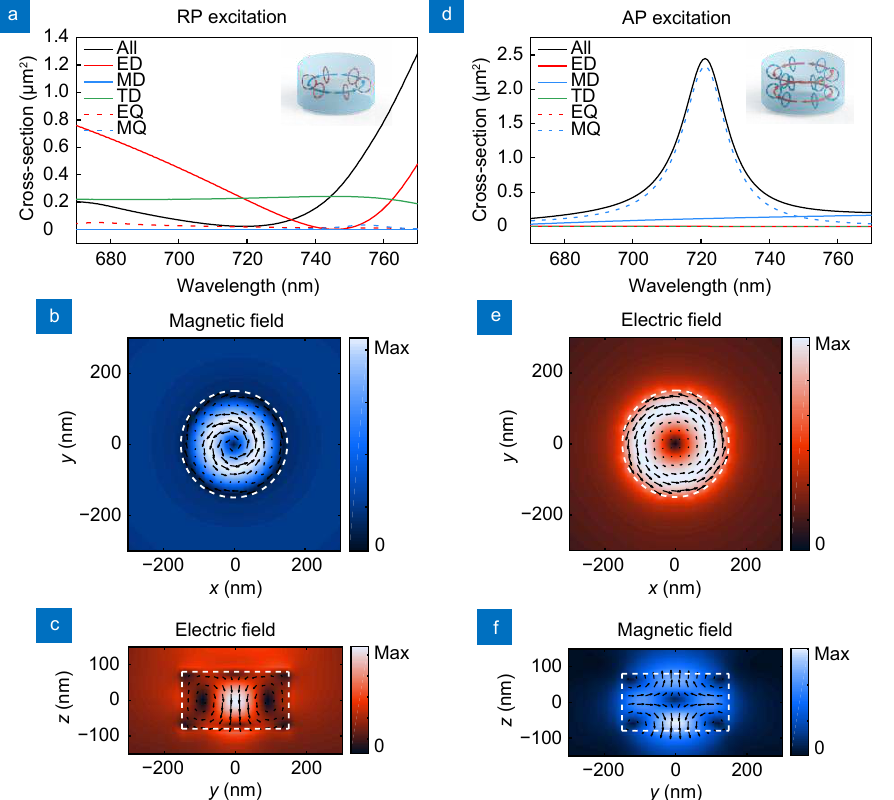
Fig. 3 | Cartesian electromagnetic multipolar decomposition results for the scattering power of a Si nanodisk under the excitation of ( a ) a tightly focused RP beam and ( d ) a tightly focused AP beam, respectively. Multipolar moments up to quadrupole are considered. The radius of Si nanod- isk is r = 150 nm while its height is h = 160 nm. The corresponding electric and magnetic field distributions at several cross sections are shown in ( b ), ( c ) and ( e ), ( f ) under the anapole condition and magnetic quadrupole (MQ) resonance, respectively. All the wavelength are 720 nm. The NA and magnification factor of the objective lens are 0.95 and 60,